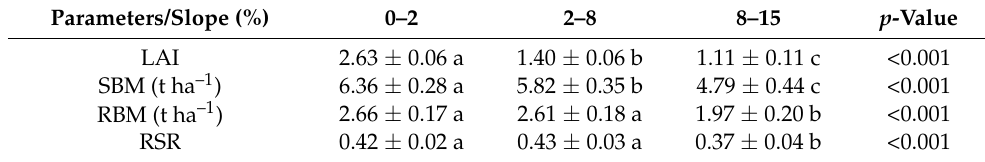
Table 2. Variation in maize growth parameters along the slope gradient in the Ruzizi